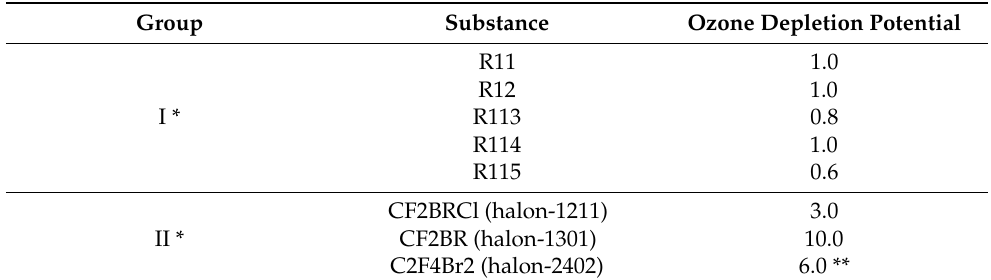
Table 1. Controlled substances with ODP values based on Annex A of the Montreal Protocol [14] and analyzed refrigerants.